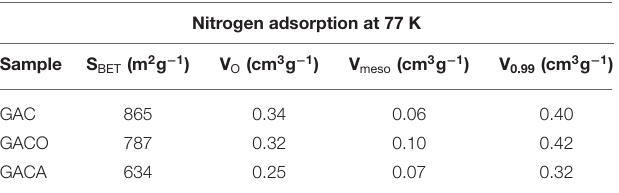
TABLE 2 | Textural parameters for carbonaceous materials obtained from the N 2 adsorption isotherms at